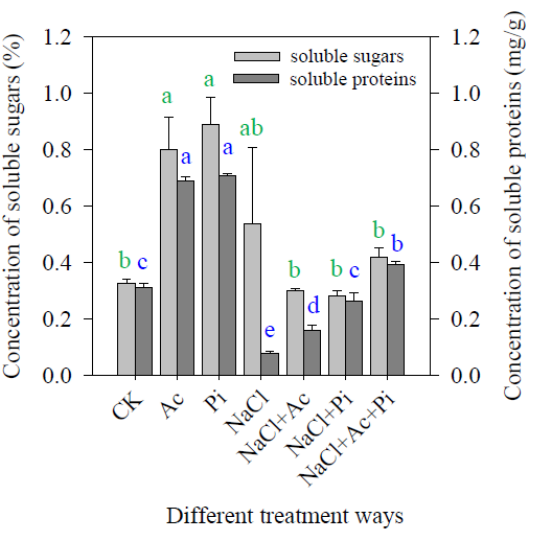
Figure 5. Concentrations of soluble sugars and proteins in leaves of tomato plants under different treatments. Results were shown as mean ± SE ( n = 3). The lower-cases of green and blue indicate statistical differences in soluble sugar and soluble protein concentrations, respectively. The means with the same lowercases indicate that the differences were insignificant ( p > 0.05).